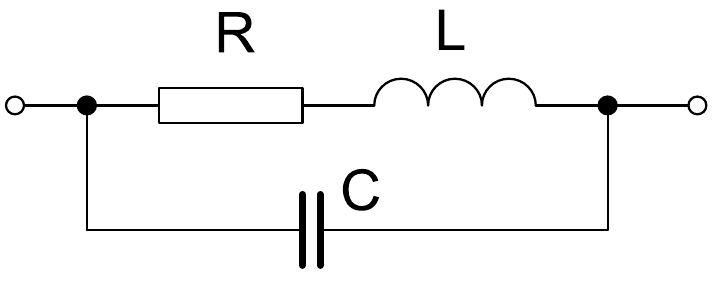
Figure 8. Equivalent electrical circuit for a coil.